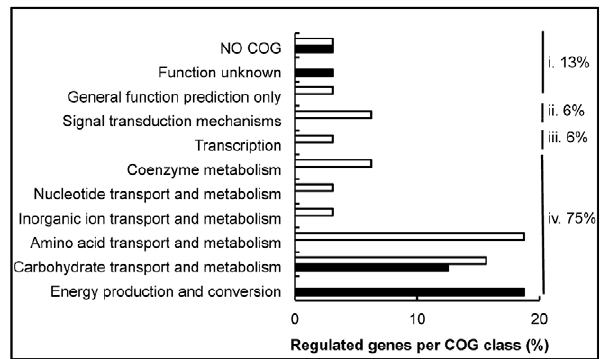
Figure 4. COG distribution of differentially regulated genes in exponentially growing D bc4707 mutant and wild type. The proportion of genes belonging to a COG class is shown as percentage of the total number of differentially regulated genes. Open bars indicate downregulated genes in the mutant compared to the wild type , solid bars represent upregulated genes. i. the proportion of regulated genes that are poorly characterized, ii. the proportion of genes with a predicted function in cellular processes and signaling, iii. the proportion of genes involved in information storage and processing, iv. the proportion of regulated genes involved in metabolism and transport.